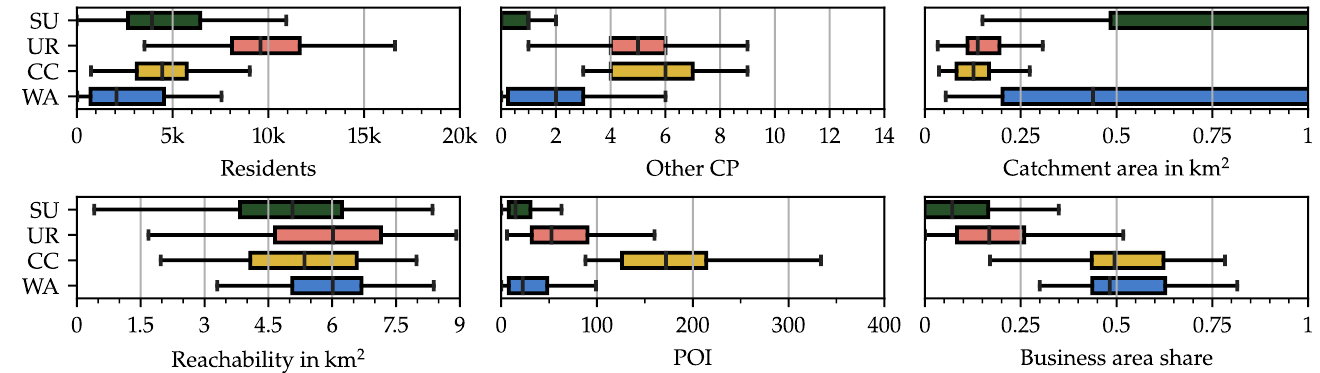
Figure 10. Characteristics of the identified charging station